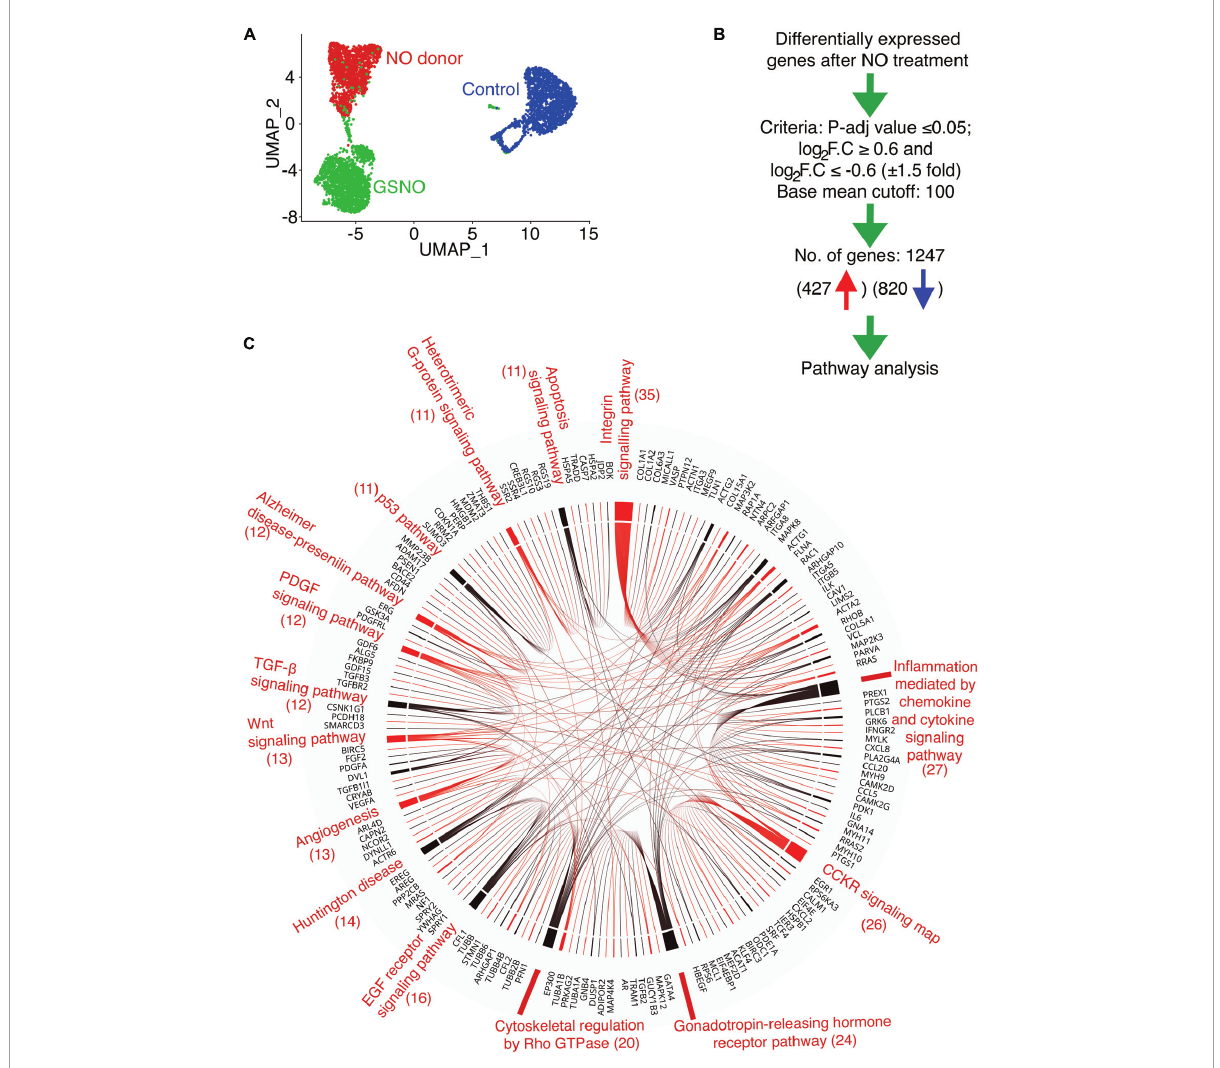
FIGURE1 Identification of altered signaling pathway in porcine aortic valve interstitial cells (pAVICs) exposed to nitric oxide (NO) donor or S-nitrosoglutathione (GSNO) by single-cell RNA sequencing (scRNA-seq). (A) Uniform Manifold Approximation and Projection (UMAP) plot of scRNA-seq expression data displays three distinct populations of pAVICs cultured in the absence (control; blue) and presence of NO donor (red) or GSNO (green) for 5 days. (B) The flow chart represents the filtering criteria for the selection of differentially expressed genes. (C) Chord plot illustrates overrepresented signaling pathways (at least > 10 genes) and corresponding differentially expressed genes identified by PANTHER pathway analysis. The number of genes is mentioned in parentheses identified in each